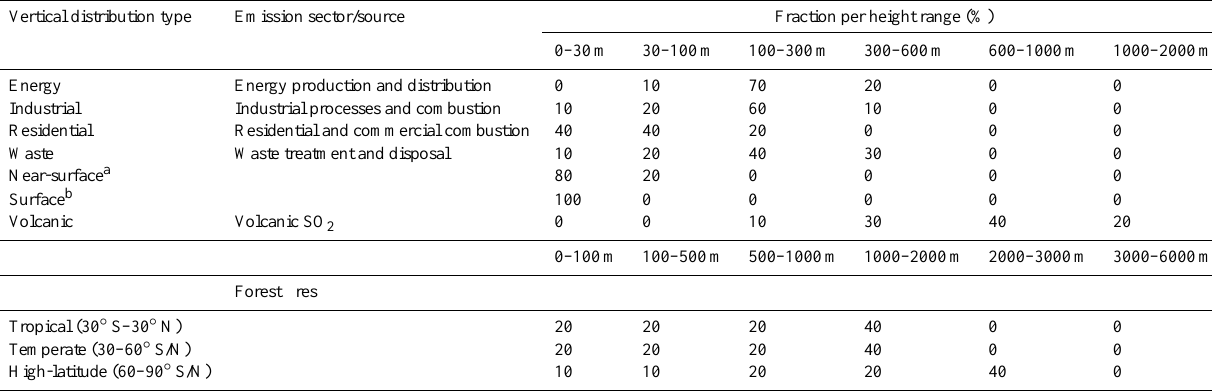
Table A1. Vertical distributions applied to the different emission sources. The emissions from aviation are distributed as provided in the CMIP5 emission data set.